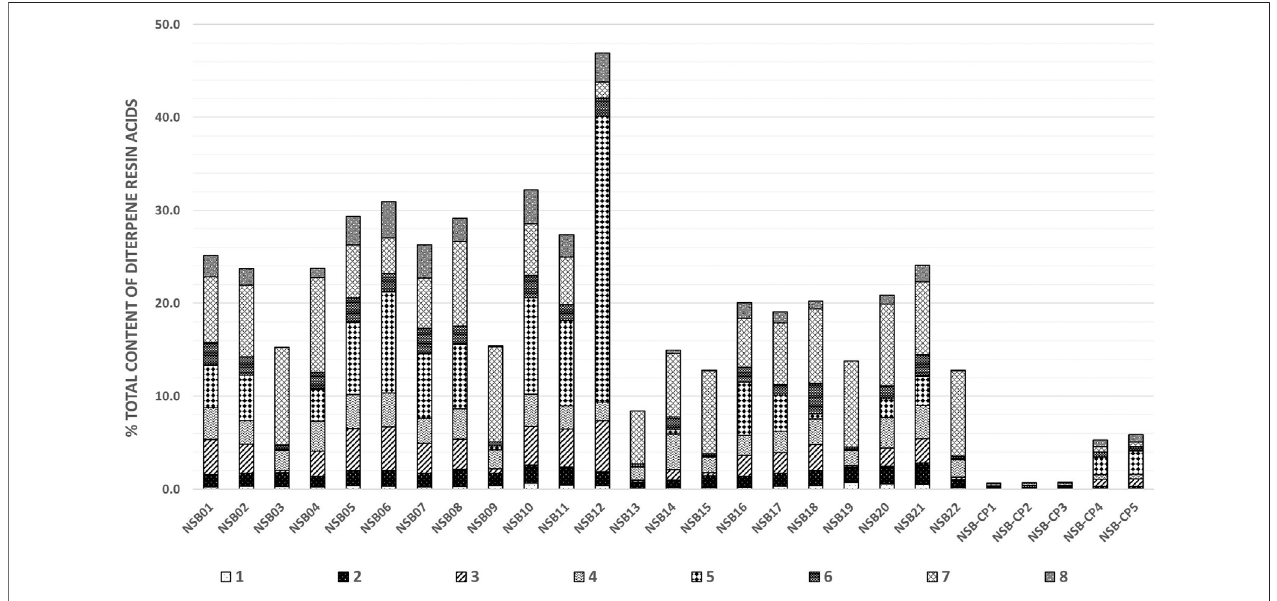
FIGURE 3 | Total contents of DRAs (% ± SD) in Norway spruce balms (samples NSB01-22) and commercial products (NSB-CP1-5).